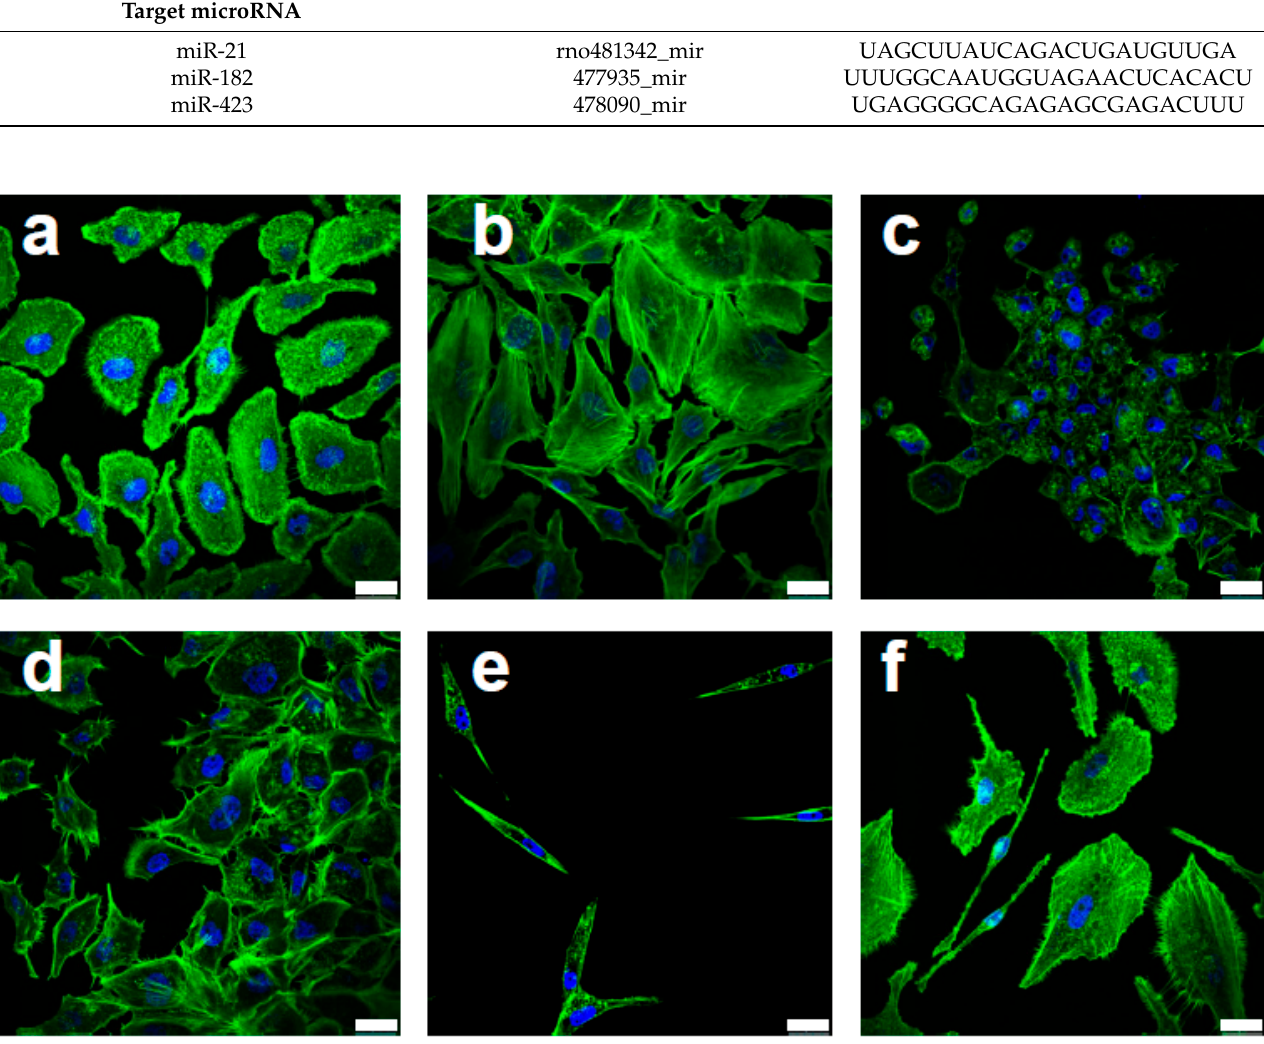
Figure 1. Efavirenz-induced morphological changes in F-actin distribution for MCF10AT breast cancer cells. ( a ) Untreated control cells. ( b – f ) Different cell morphologies were observed in Efavirenz-treated MCF10AT cells: ( b ) flattened and angular morphology, ( c ) cell death phenotype, ( d ) neuron-like cell projection, ( e ) quiescent phenotype and ( f ) migrating cells presenting filopodia and clear direction. Cells were stained with Phalloidin (green, for F-actin detection) and DAPI (blue, for nucleus detection). Scale bar: 25 µ m. These images were produced by Leica SP5 confocal microscope: objectives lenses—63 × /1.40